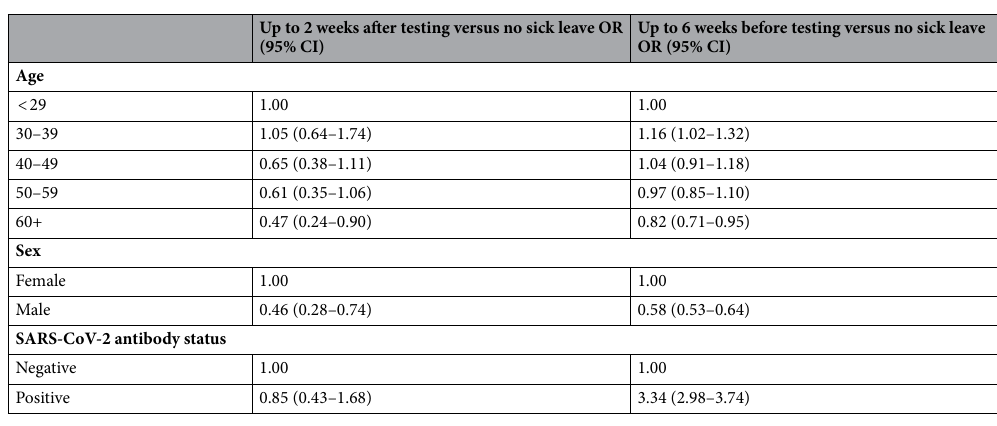
Table 2. Association between covariates and sick leave, mutually adjusted.